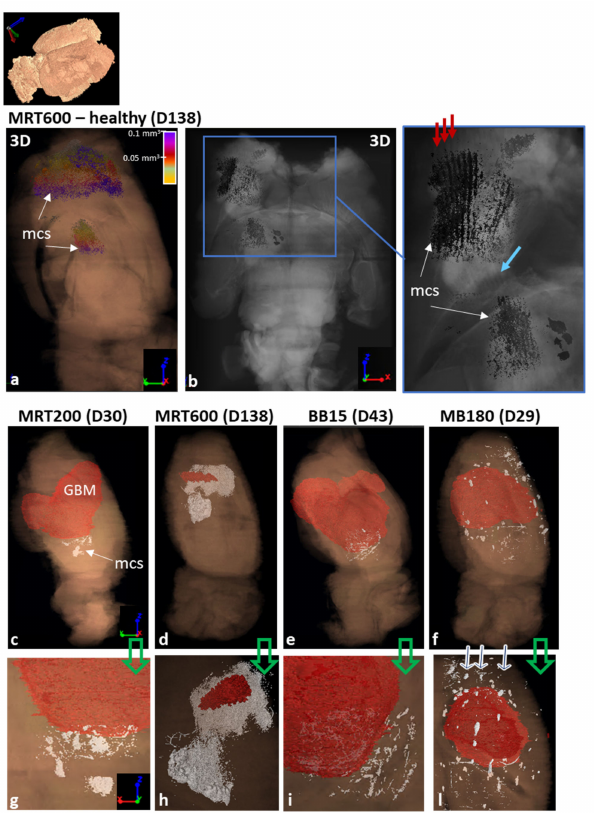
Figure 8. ( a , b ) Three-dimensional (3D) images of the distribution of microcalcifications (mcs) for a healthy MRT600-treated sample in a sagittal and axial view, respectively. The ( d ) zoom enhances that microcalcifications are distributed along the MRT paths (red arrows) and the green arrow points out that the MRT paths are bended along their track. ( c – f ) The tumor and microcalcifications 3D rendering, in a sagittal view, within the entire brain organ for an MRT200, MRT600, BB15 and MB180—irradiated sample respectively. ( g – j ) The zoomed rendering, in axial view, of ( c – j ) respectively. All tumor and brain volumes are presented in semi-transparency while microcalcifications are co-registered to the other volumes as solid white